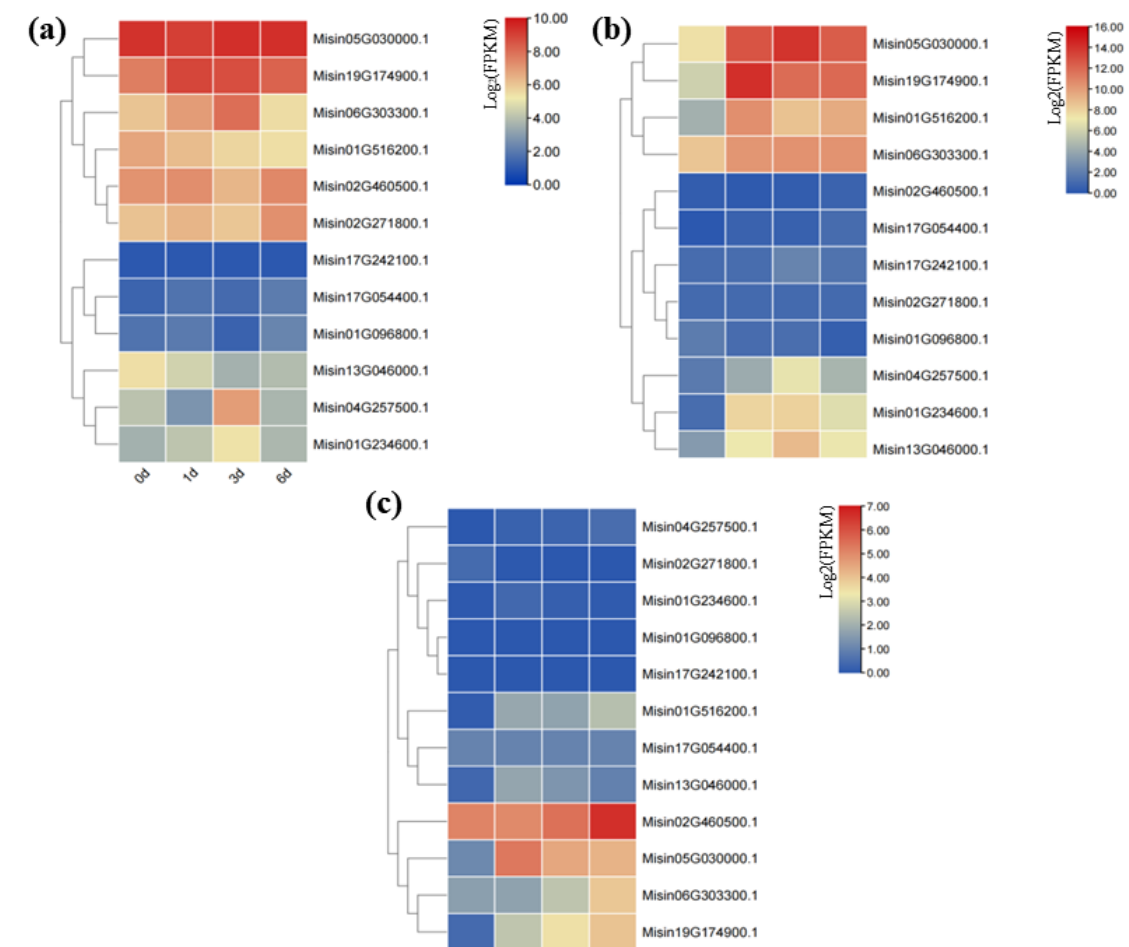
Figure 7. Expression patterns of 12 M. sinensis HD-Zip genes in different abiotic stresses: ( a ) a heatmap of 12 M. sinensis HD-Zip genes under drought stress; ( b ) a heatmap of 12 M. sinensis HD-Zip genes under salt stress; ( c ) a heatmap of 12 M. sinensis HD-Zip genes under chromium stress. Expression changes of M. sinensis HD-Zip genes under abiotic stresses were shown by log2 change folds, and the levels of expression were illustrated by color gradations.